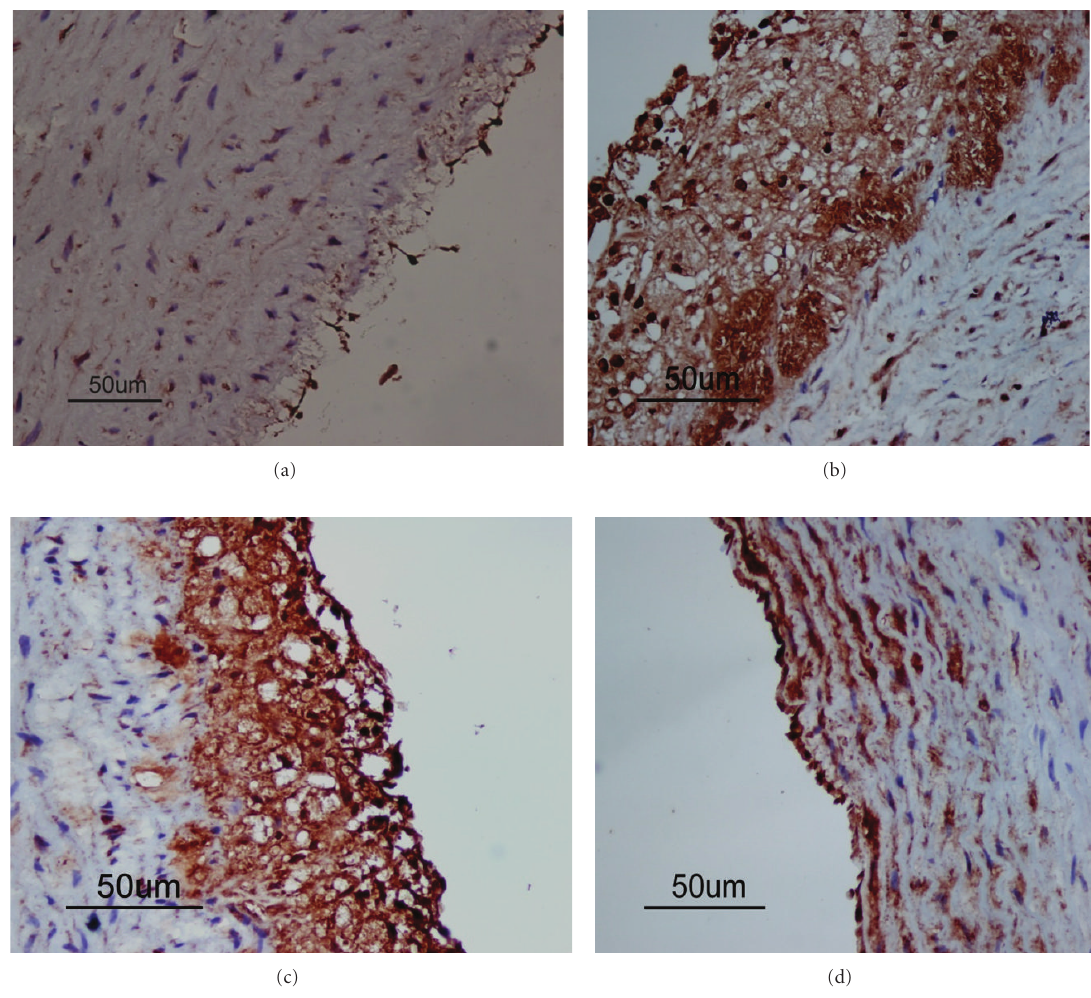
Figure 4: Fibrinogen deposition in arteries from di ff erent groups with immunohistochemistry. Areas of positive fibrinogen deposition are shown in brown. The representative photographs of immunohistochemistry from di ff erent groups are shown. In the control group (a), the deposition of fibrinogen in the intima was minimum, while in the HFD group (b), there was much more fibrinogen deposition in the intima. In the rosuvastatin group (c), there was less fibrinogen deposition in the intima compared with HFD group. In the atRA group (d), the fibrinogen deposition was significantly less in comparison with either HFD or rosuvastatin group (magnification ×